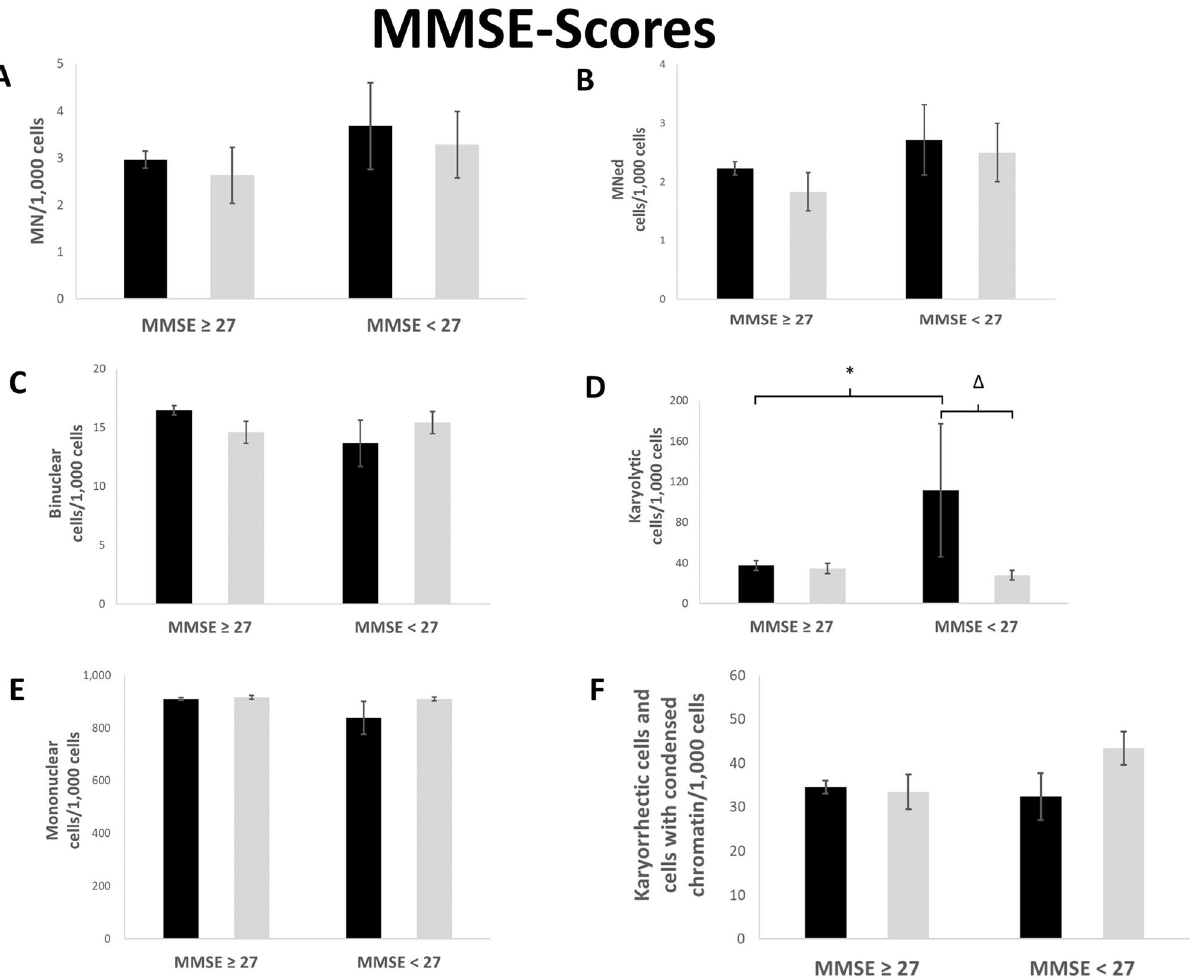
Figure 2. Rate of MN ( A ), MNed cells ( B ), binucleated cells ( C ), karyolytic ( D ), mononuclear ( E ) and karyorrhectic cells and cells with condensed chromatin ( F ) per 1000 cells. Mean of each group ± standard error. Black bars represent data from reference, grey bars represent data from patients. n (MMSE ≥ 27 reference): 314; n (MMSE < 27 reference): 14. n (MMSE ≥ 27 patients): 35; n (MMSE < 27 patients): 43. Asterisk represent p value < 0.05 after statistical evaluation referring to MMSE ≥ 27. Delta represent p value < 0.05 after statistical evaluation referring to